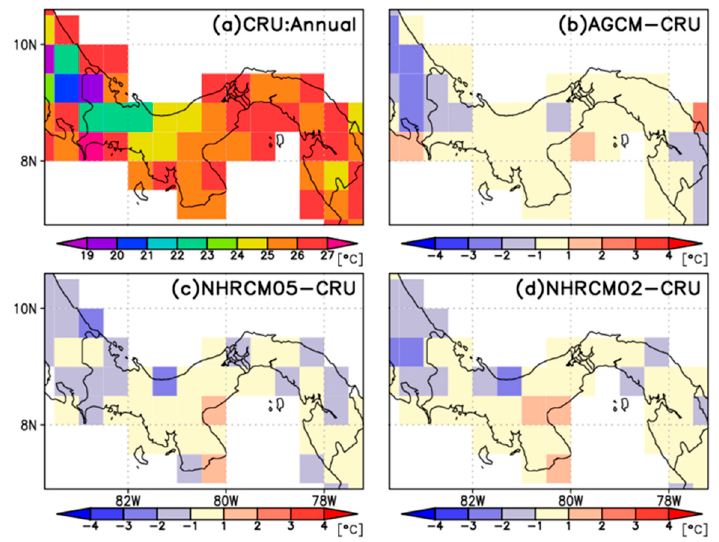
Figure 2. Geographic evaluation of 20-year mean annual surface air temperature derived from ( a ) CRU (CRU_TS4.05), and biases in ( b ) MRI-AGCM, ( c ) NHRCM05, and ( d ) NHRCM02. Values in biases are difference between simulations and CRU observations. See Table 2 for quantitative evaluation.